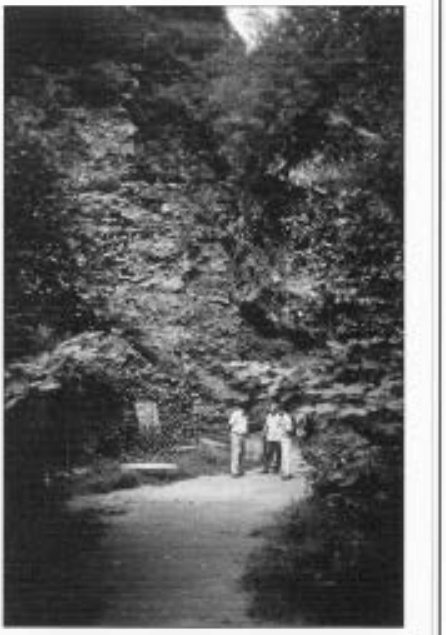
Figure 1 Zhoukoudian, locality 1: view towards the key stratigraphic section, par­ tially obscured by